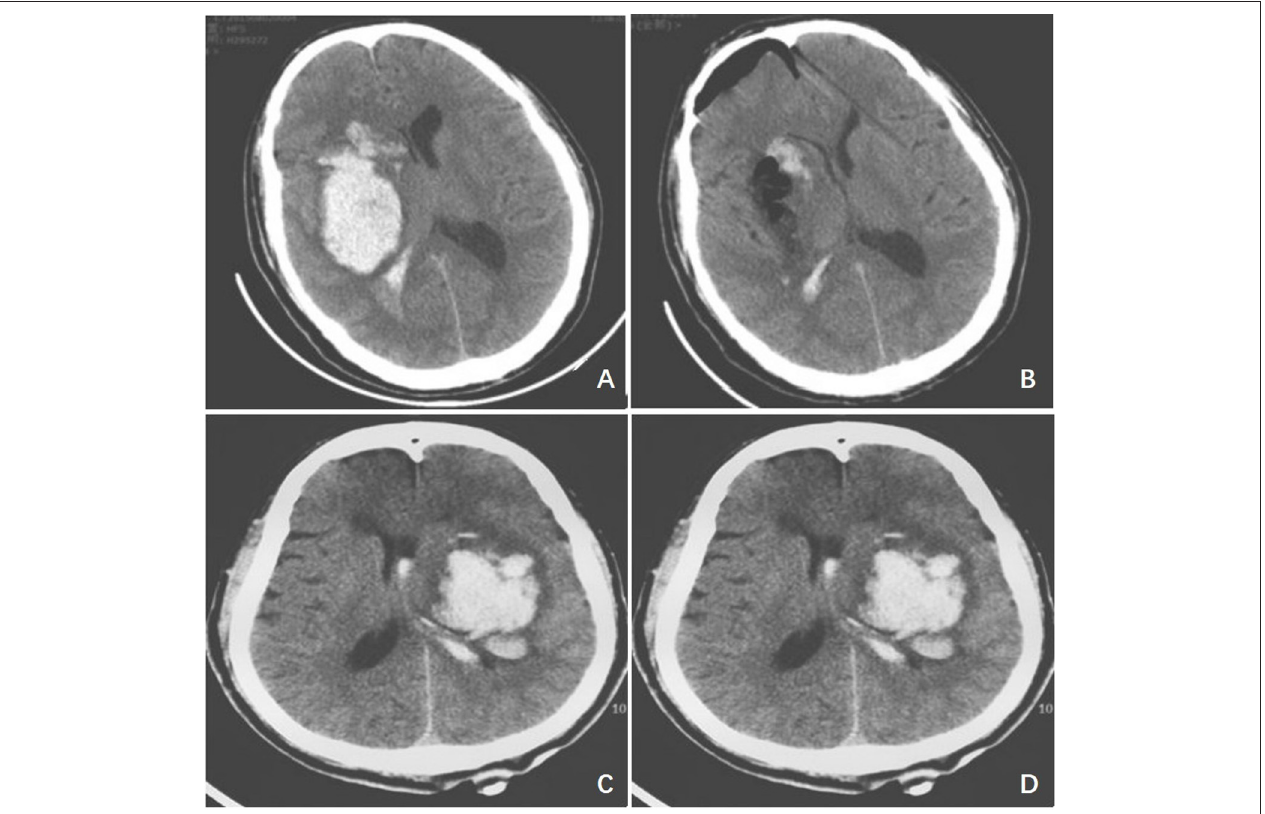
FIGURE 2 | Typical case imaging images. (A) The preoperative cerebral CT image of the study group; (B) The postoperative cerebral CT image of the study group; (C) The preoperative cerebral CT image of the control group; (D) The postoperative cerebral CT image of the control